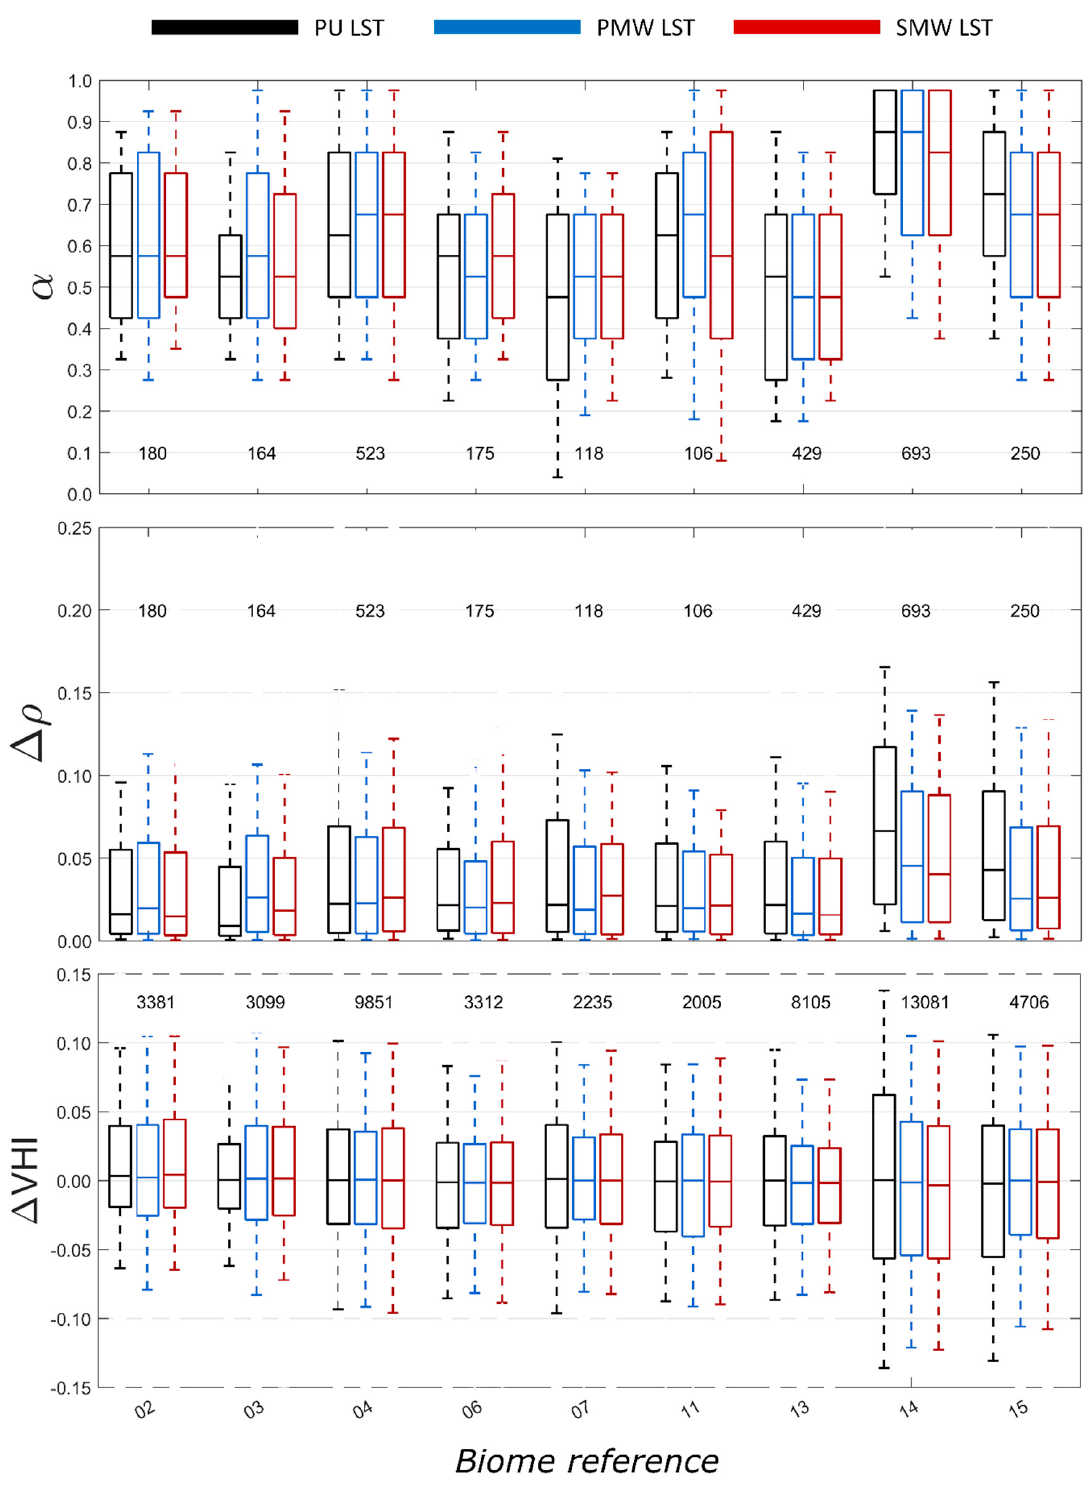
Figure 5. Distribution of α ( top panel), Δρ ( middle panel), and Δ VHI ( bottom panel) as estimated with PU LST (black), CM-SAF PMW LST (blue), and CM-SAF SMW LST (red) for the different biomes (identified by the labels described in Figure 4). Box and whiskers represent percentiles 10, 25, 50, 75, and 90. For each biome, the numbers indicate the respective number of pixels of the sample.